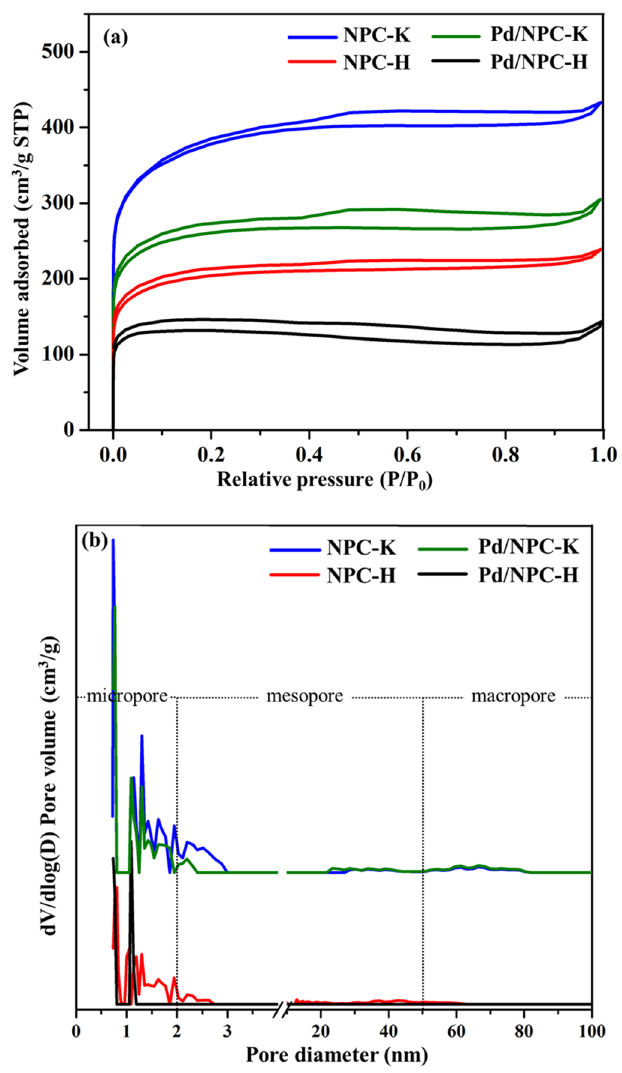
Figure 3. ( a ) N 2 adsorption–desorption isotherm and ( b ) pore size distribution plot of NPC-K, NPC-H, Pd/NPC-K, and Pd/NPC-H.